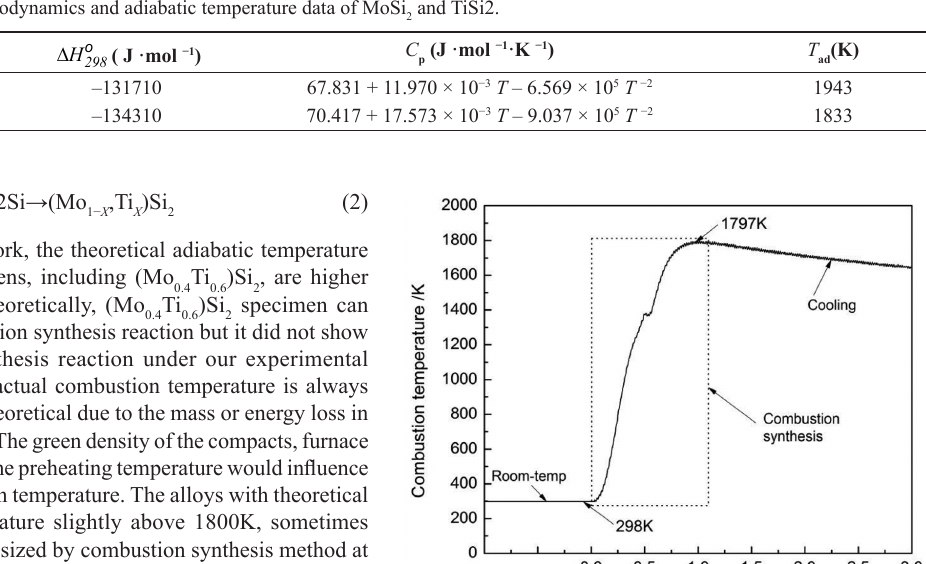
observed in Figure 4. The combustion synthesis reaction of (Mo Ti )Si , (Mo Ti )Si , (Mo Ti )Si , (Mo Ti ) 0.9 0.1 2 0.8 0.2 2 0.7 0.3 2 0.6 0.4 Si and (Mo Ti )Si was sustained 0.62s, 0.76s, 0.75s, 2 0.5 0.5 2 0.95s and 1.09s (AB stage) respectively. The time